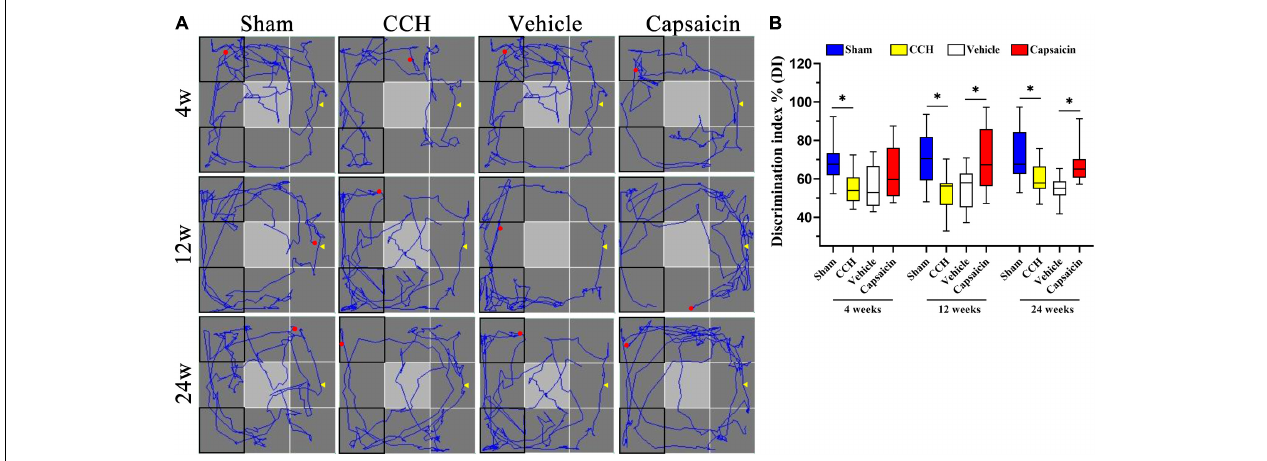
FIGURE 6 | Capsaicin relieves the short-term recognition memory impairment induced by CCH. (A) The path diagram on the left shows the rats’ typical performance in the ORT. (B) The boxplot on the right shows the discrimination index (DI) in the ORT [the ratio between the time spent exploring the novel object (N) and the total exploration time (N + F)]. Data are presented as the mean ± SD. * P < 0.05. Data were analyzed by one-way ANOVA followed by the post hoc LSD test. N, the time spent interacting with the novel object; F, the time spent contacting the familiar object; N + F, the total exploration time.